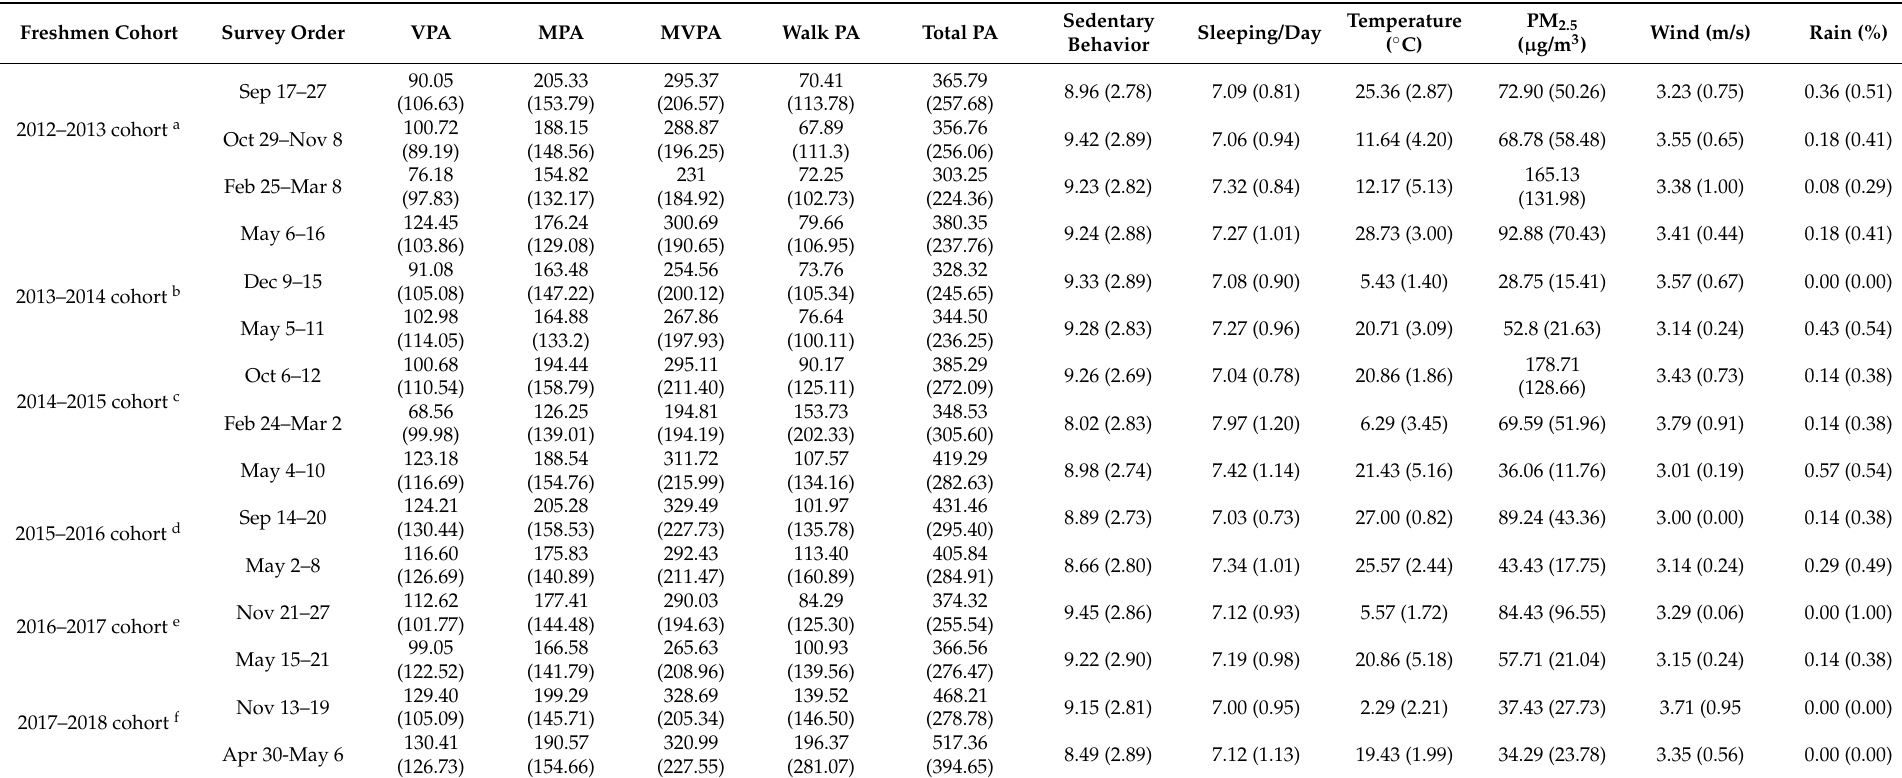
Table 2. Average PA, SB and sleep duration, temperature and other environmental variables in the last seven days before the